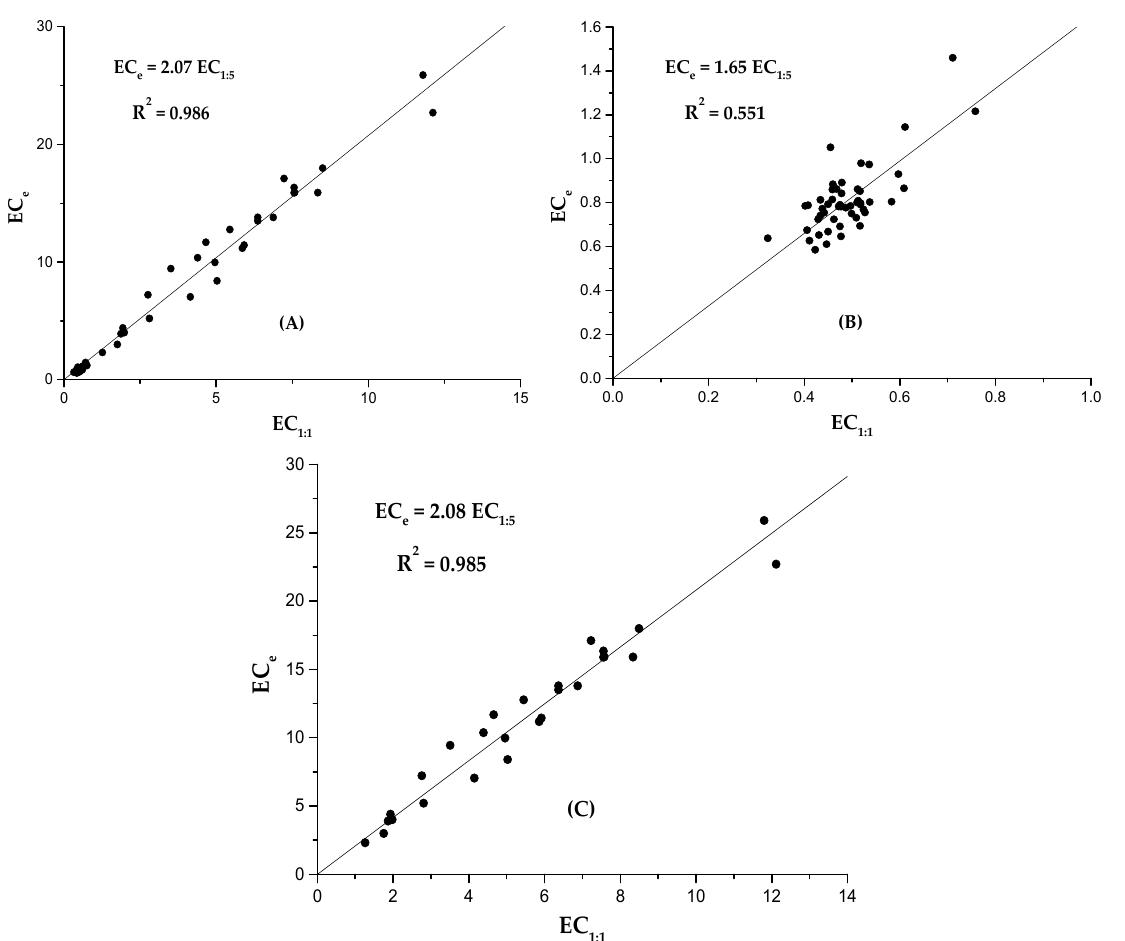
Figure 2. Relationship between EC e and EC 1:1 for NRCS extraction method. A: all soil samples, B: soil samples range EC e < 3 dS m − 1 , C: soil samples range EC e > 3 dS m − 1 .